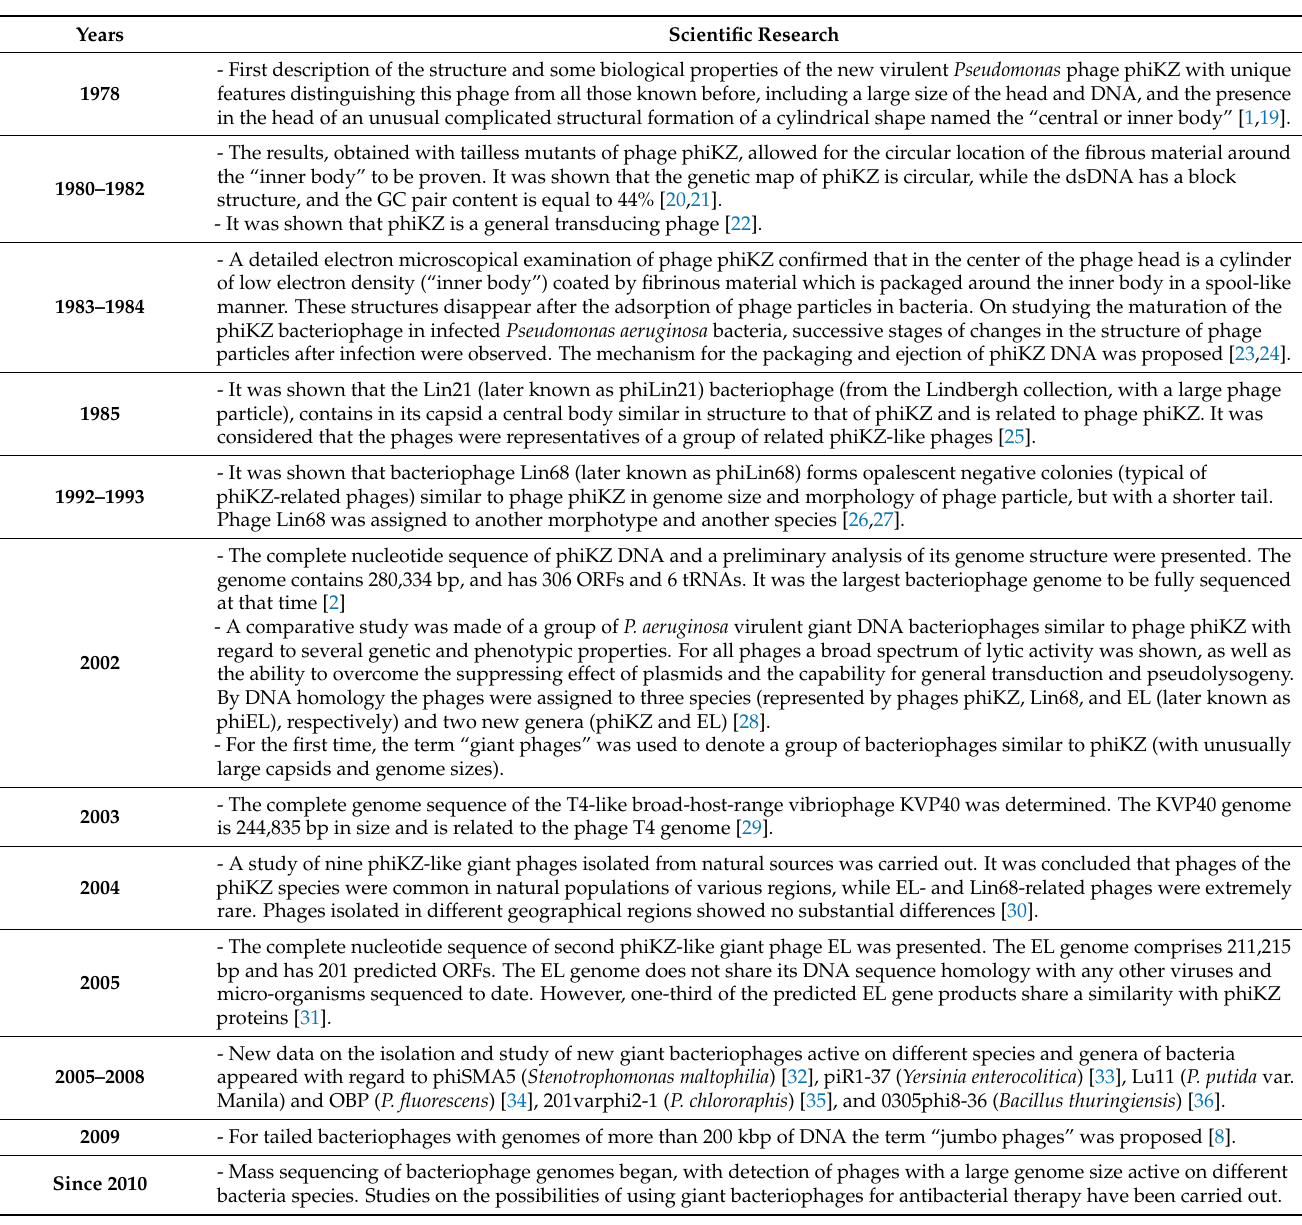
Table 1. Main steps in the early research history of giant